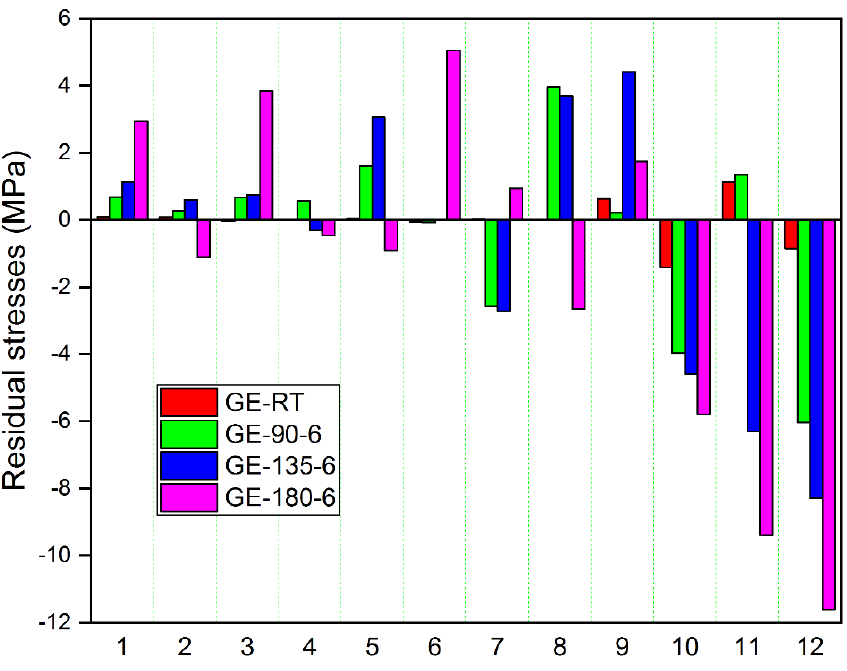
Figure 6. Longitudinal residual stress in each lamina determined from recorded longitudinal strains for all GE laminates.